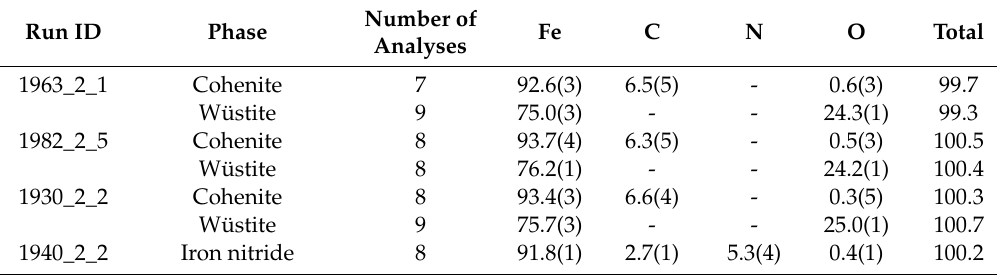
Table 2. Average compositions (wt %) of synthesized